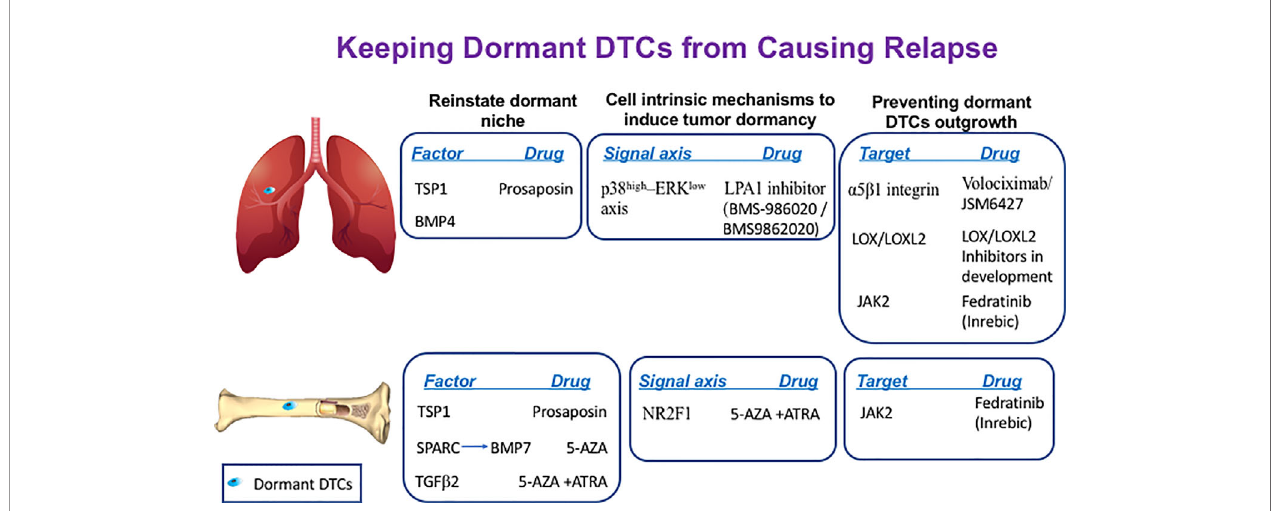
FIGURE 1 | Keeping dormant DTCs from causing recurrence. The following scheme illustrates the different sites where dormant DTCs reside and potential factors, signaling axis or targets that can be manipulated by the indicated drugs to maintain their long-term quiescence by either reinstating the dormant niche, inducing cell- intrinsic dormancy mechanisms and/or preventing dormant DTCs engagement with their ‘ permissive niche ’